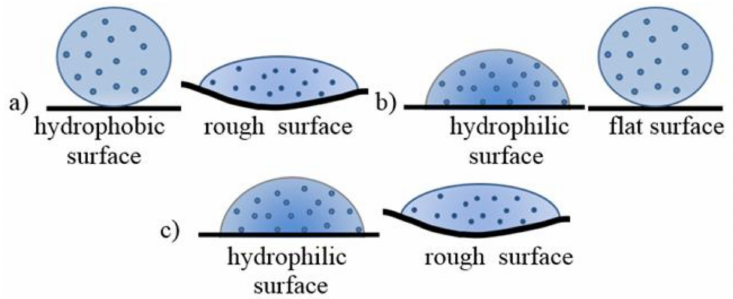
Figure 9. A shape of colloid drop on different textile surfaces: ( a ) PP; ( b ) PET; and ( c ) PA.